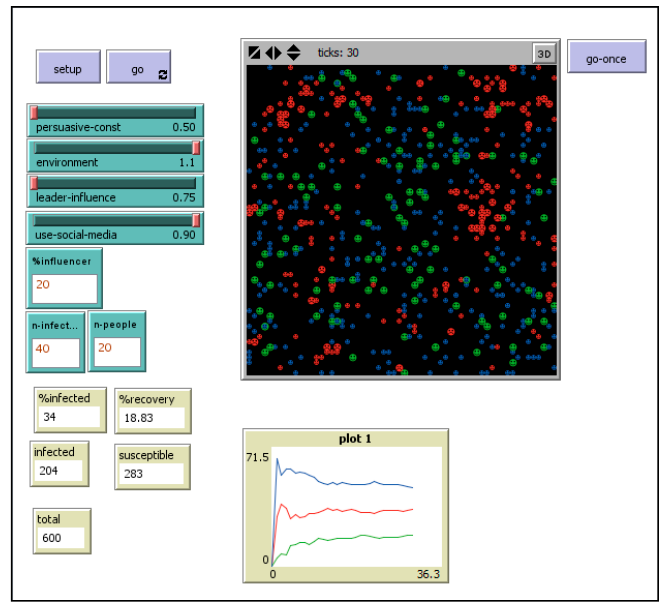
Figure 2. Netlogo interface.